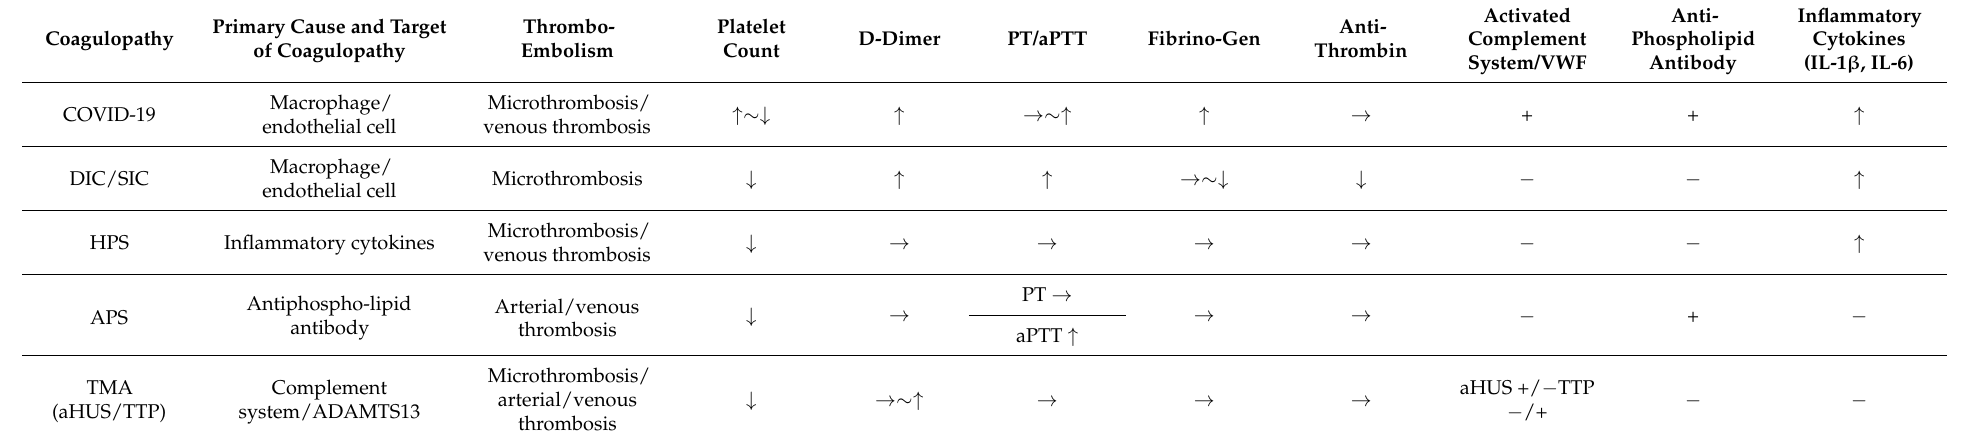
Arrows indicate direction of change; “+/ − ” indicates presence or absence. Abbreviations: DIC, disseminated intravascular coagulation; SIC, sepsis-induced coagulopathy; HPS, hemophagocytic syndrome; APS, antiphospholipid syndrome; TMA, thrombotic microangiopathy; aHUS, atypical hemolytic uremic syndrome; TTP, thrombotic throm- bocytopenic purpura; PT, prothrombin time; aPTT, activated partial thromboplastin time; VWF, von Willebrand factor; IL, interleukin. Reproduced without modification from Iba et al. 2022 [66] under a Creative Commons Attribution-NonCommercial-NoDerivatives 4.0 International (CC BY-NC-ND 4.0) license